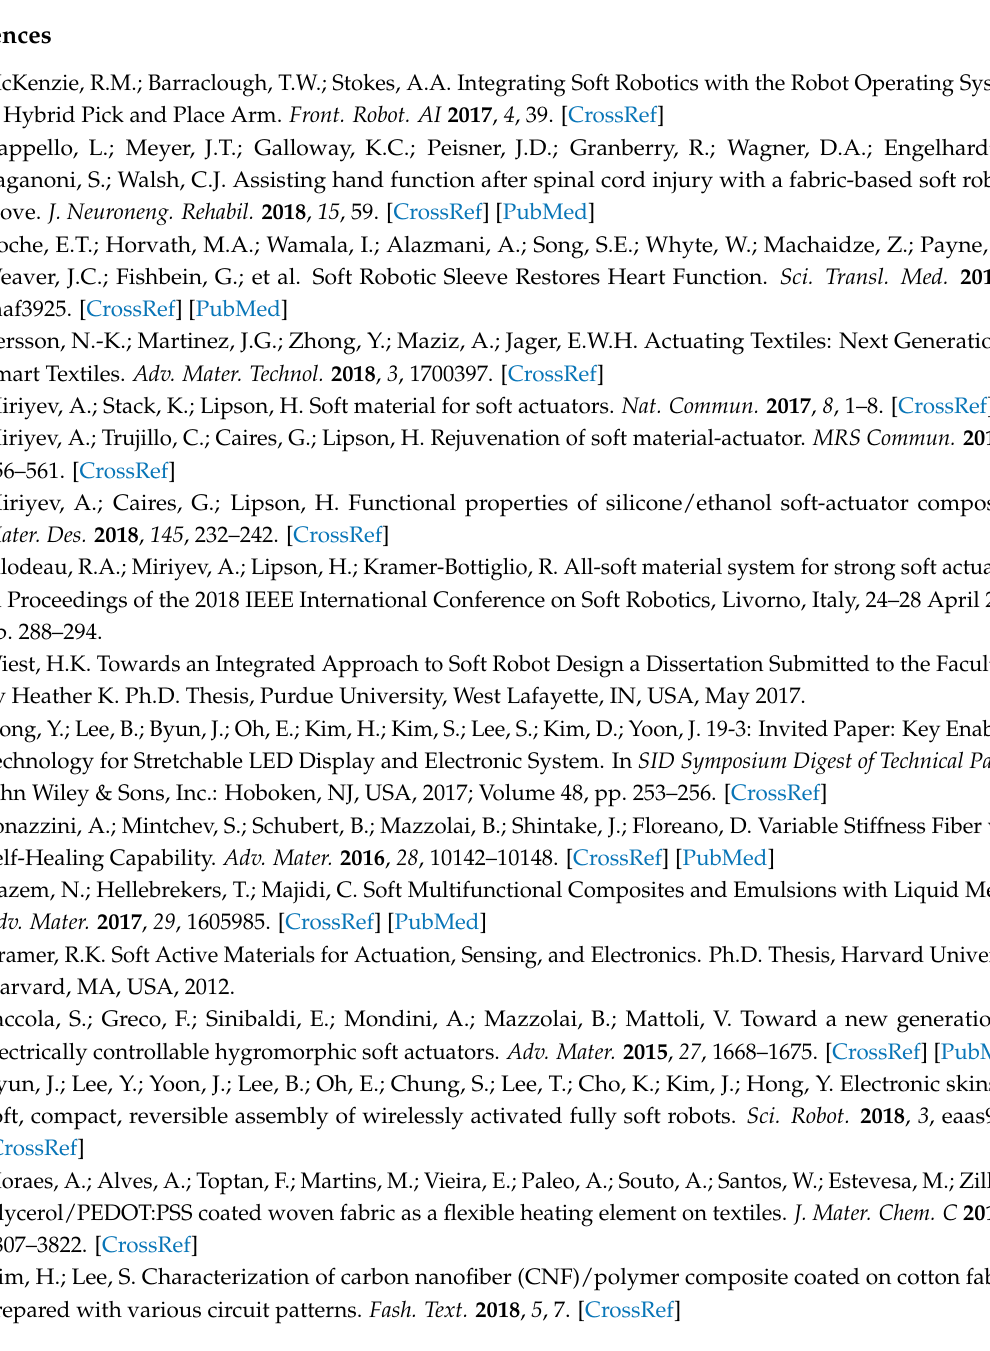
Figure A19. Spiral Fabric Design KS-6. Kirigami short cuts, Thermionyx fabric.